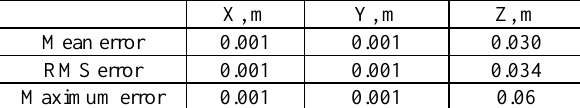
Table 4. Accuracy estimation of transforming geodetic network point coordinates Table 5. Absolute accuracy estimation of MLS data